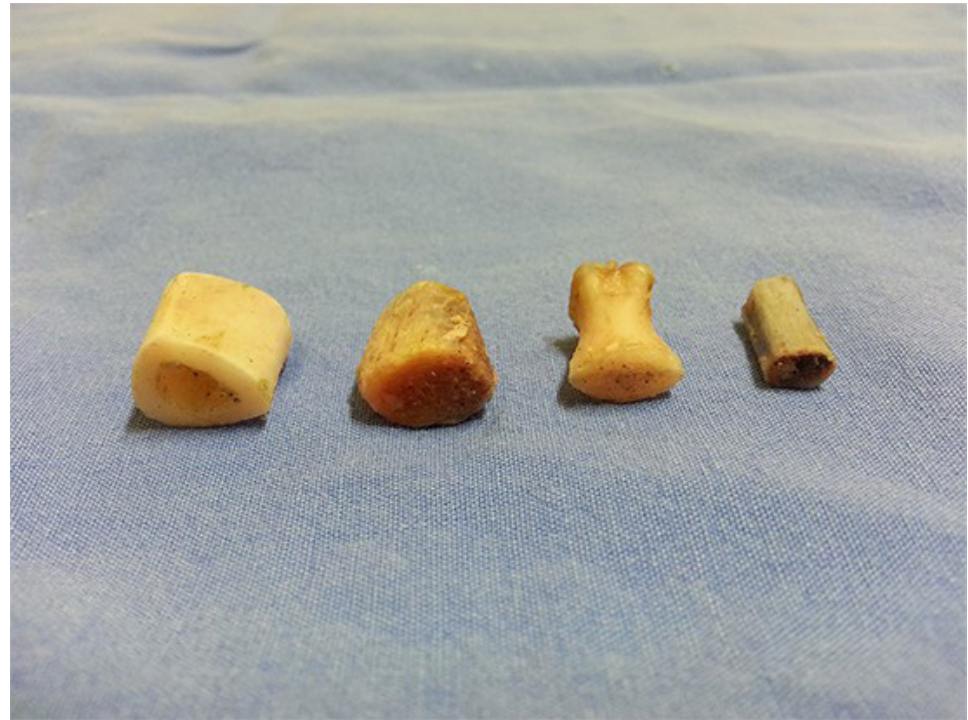
Figura 1. Enxertos da tíbia, asa do ílio, vértebra coccígea e costela,